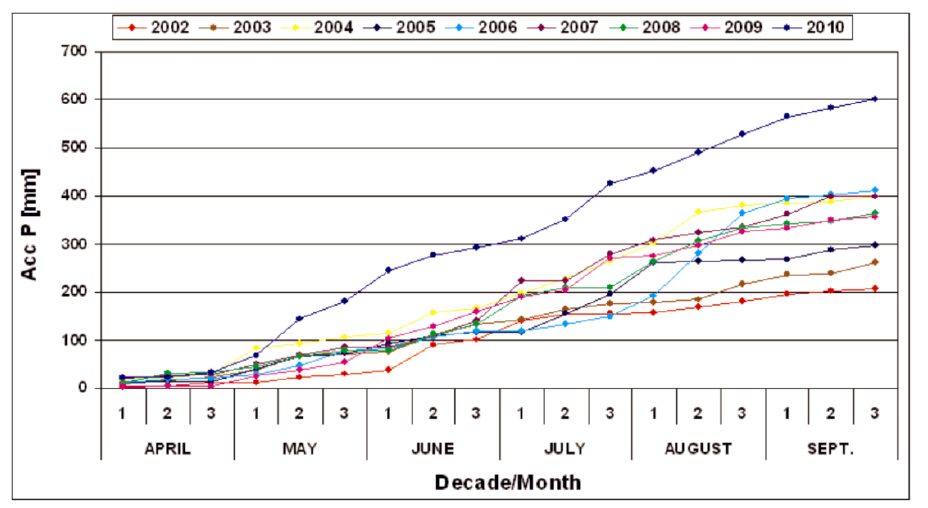
Figure 3. Accumulated values of precipitation (Acc